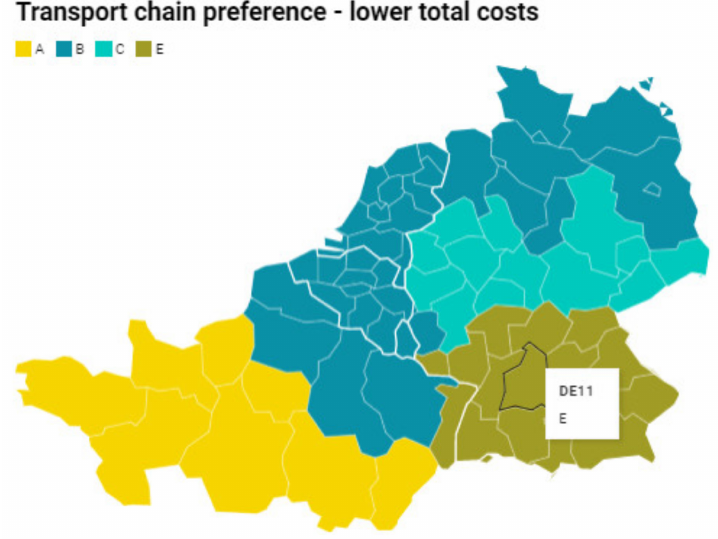
Figure 11. Transport chain preference for lower total costs, not taking the current internalisation state into account (created with